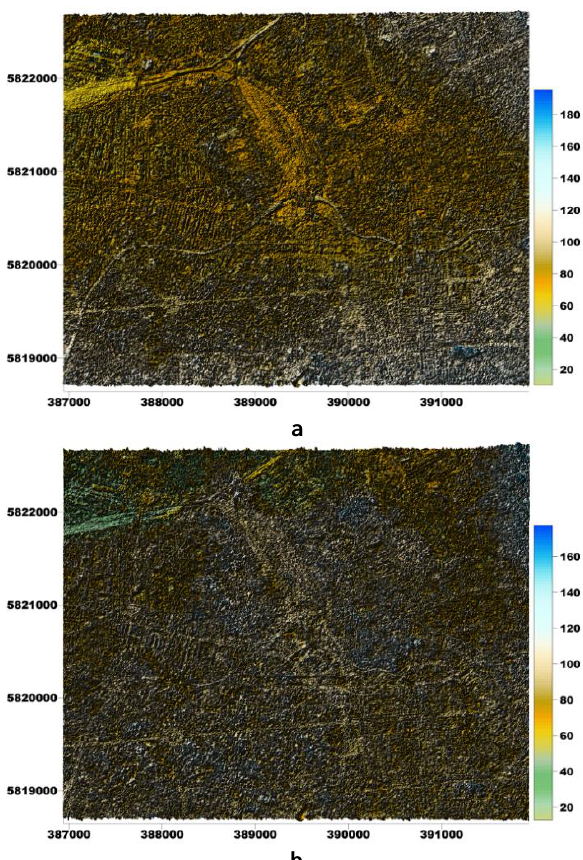
Figure 5. Generated DSMs (a= DSM 1, b= DSM 2) To achieve 100% successful vertical accuracy assessment the horizontal offsets between tested DSMs and REFRAD were calculated and eliminated with horizontal shifting based on cross correlation. Table 2 shows the eliminated horizontal offsets in X and Y directions